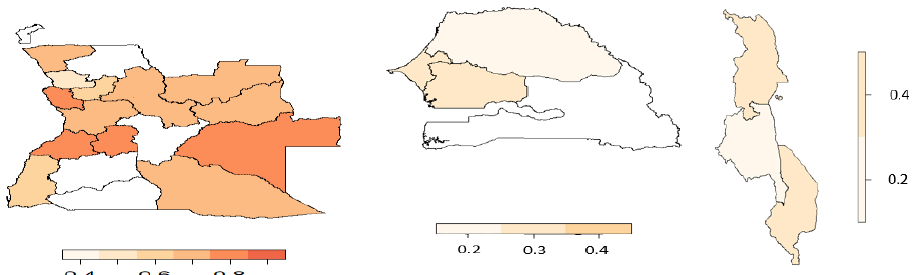
Figure 7. Joint probability of a child being not malnourished and not anaemic. ( Left ) Angola, ( mid- dle ) Senegal, and ( right ) Malawi.